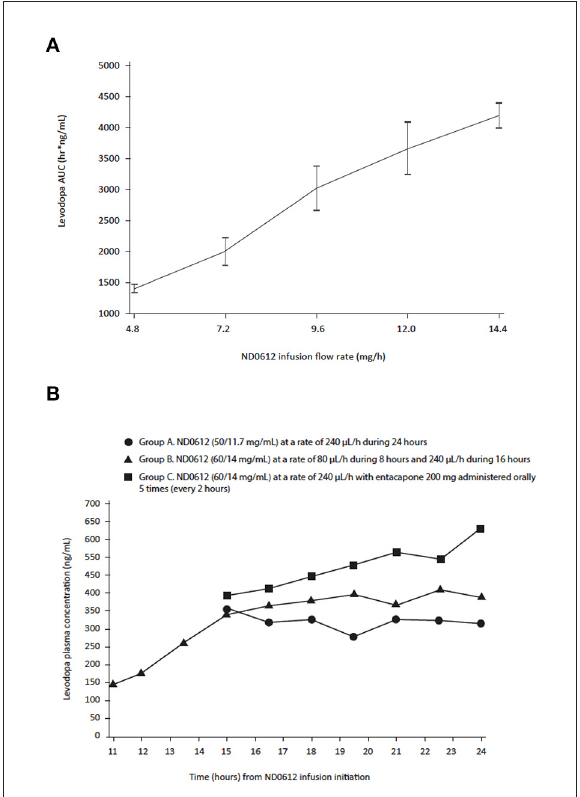
FIGURE1 Levodopa (A) area under the curve (B) concentrations over time following SC infusion with ND0612 in healthy volunteers. (A) AUC comparisons between cohorts were made on the 15- to 24-h time period after the start of the infusion (B) Blood samples were collected at 11, 12, 13.5, 15h for Group B only, and 16.5, 18, 19.5, 21, 22.5, and 24h for all three